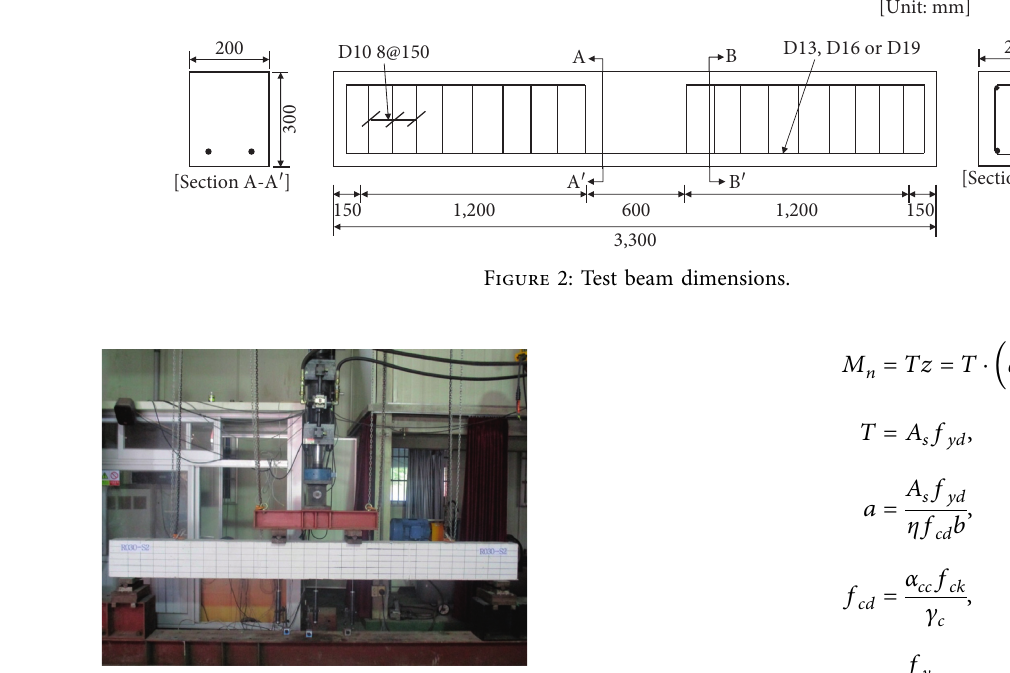
Figure 3: Test setup for the beam